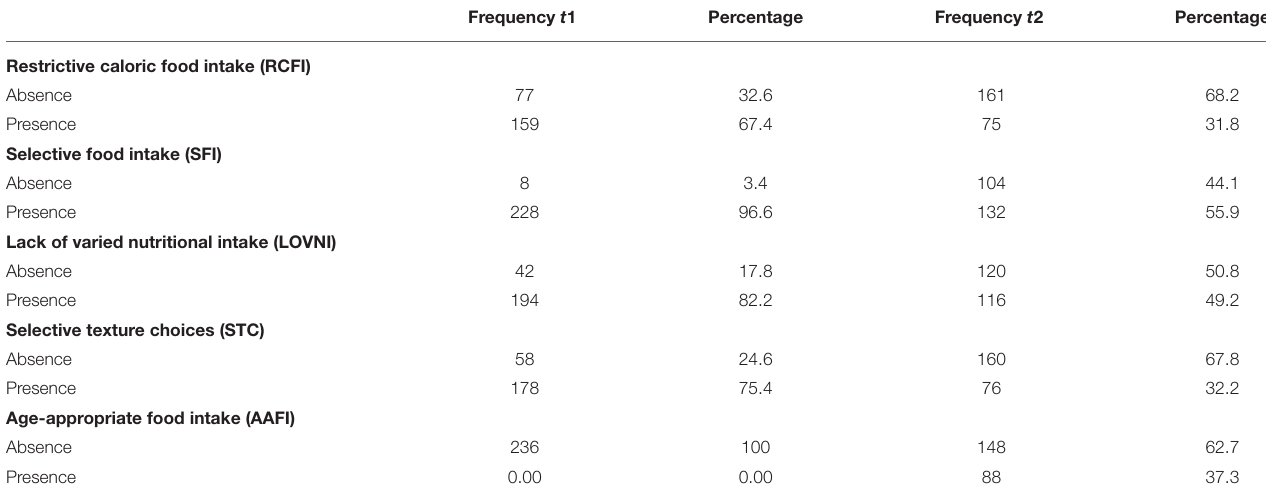
TABLE 2 | Comparison of frequencies and percentages of dependent variables between t 1 and t 2 ( N =